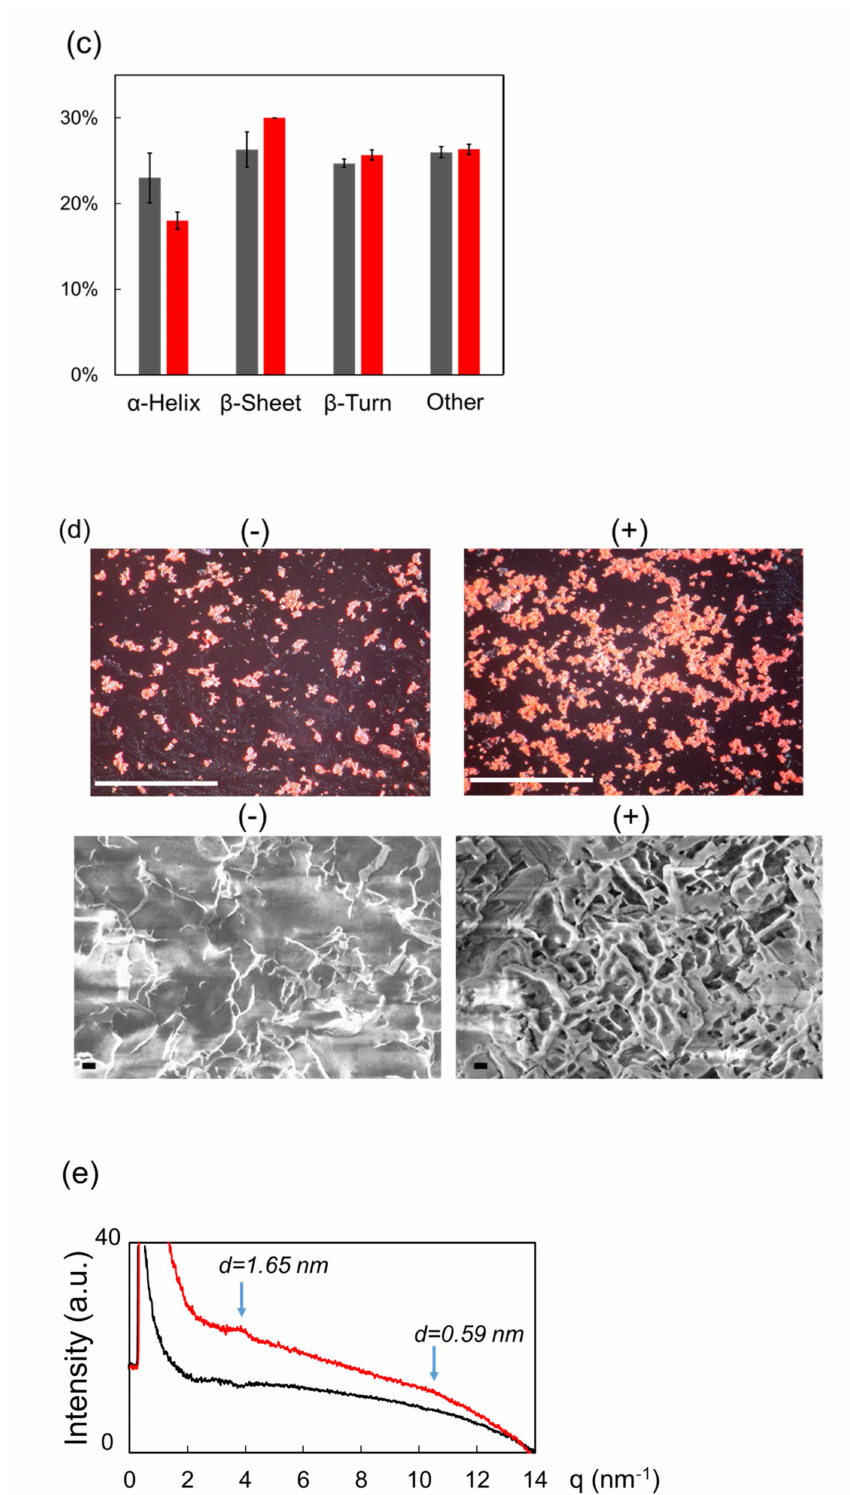
Figure 3. Irradiation Effect of submillimeter wave on lysozyme fibril. ( a ) Thermography camera observation. ( b ) Mid-infrared spectra before (black) and after (red) irradiation. ( c ) Proportions of protein secondary conformations. The color category is the same as ( b ). ( d ) Congo red staining (upper) and SEM observation (bottom) before ( − ) and after (+) irradiation. White bar: 500 µ m; black bar: 1 µ m. ( e ) SAXS spectra before (black) and after (red) irradiation: d value equals 2 π q − 1